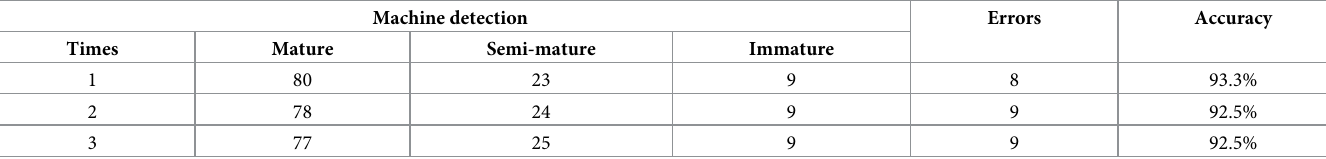
Table 1. Grading results of tomato maturity